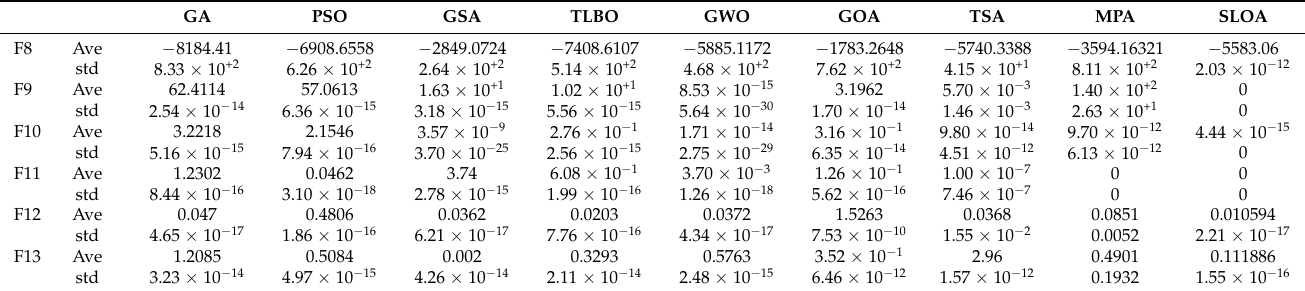
Table 3. Optimization results of SLOA and other algorithms on high dimensional test